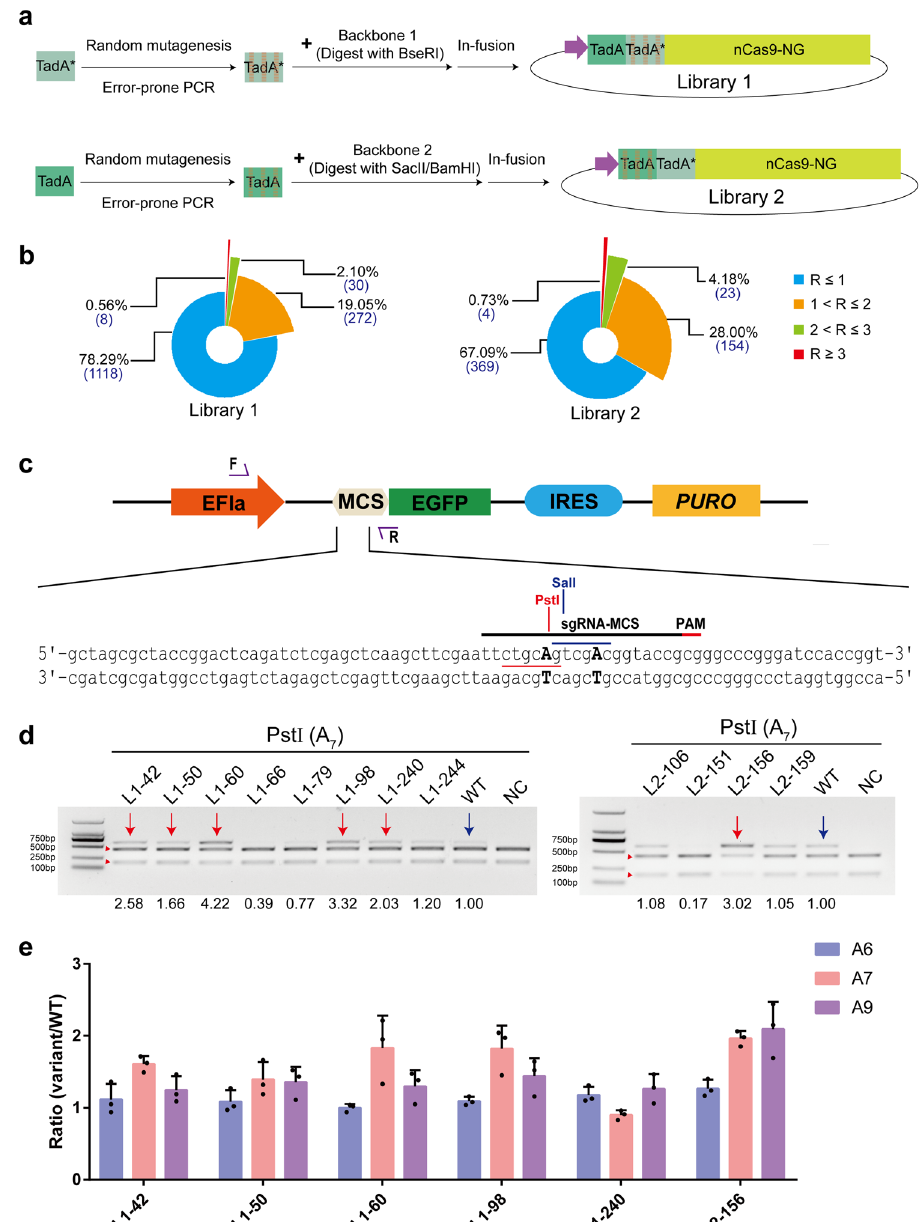
Fig. 2 Evolution of NG-ABEmax variants with improved A • T to G • C base editing activity. a Scheme of libraries generation design. The library 1 contain TadA* mutations and the library 2 contain TadA mutations. Red lines represent the point mutations. b Summary of the library 1 and library 2 (A • T to G • C base editing ef fi ciencies at A12). R represents the ratio of editing ef fi ciency of mutants to NG-ABEmax. c Schematic for assessing A • T to G • C base editing ef fi ciencies of NG-ABEmax variants using the HEK293-PME cell line. Restriction sites are highlighted in red and blue. d Agarose gel electrophoresis results of testing editing ef fi ciency of NG-ABEmax variants with PstI. Cleaved bands from PstI are labeled with red triangle. The amplicon is 606-bp. The variants with high-activities are highlighted with red arrows. WT represents NG-ABEmax and highlighted with blue arrows. e Boosted editing ef fi ciencies of selected variants via EGFP -based reporter system. Error bars indicate mean ± s.d. ( n = 3 independent experiments). Source data are available in the Source data fi